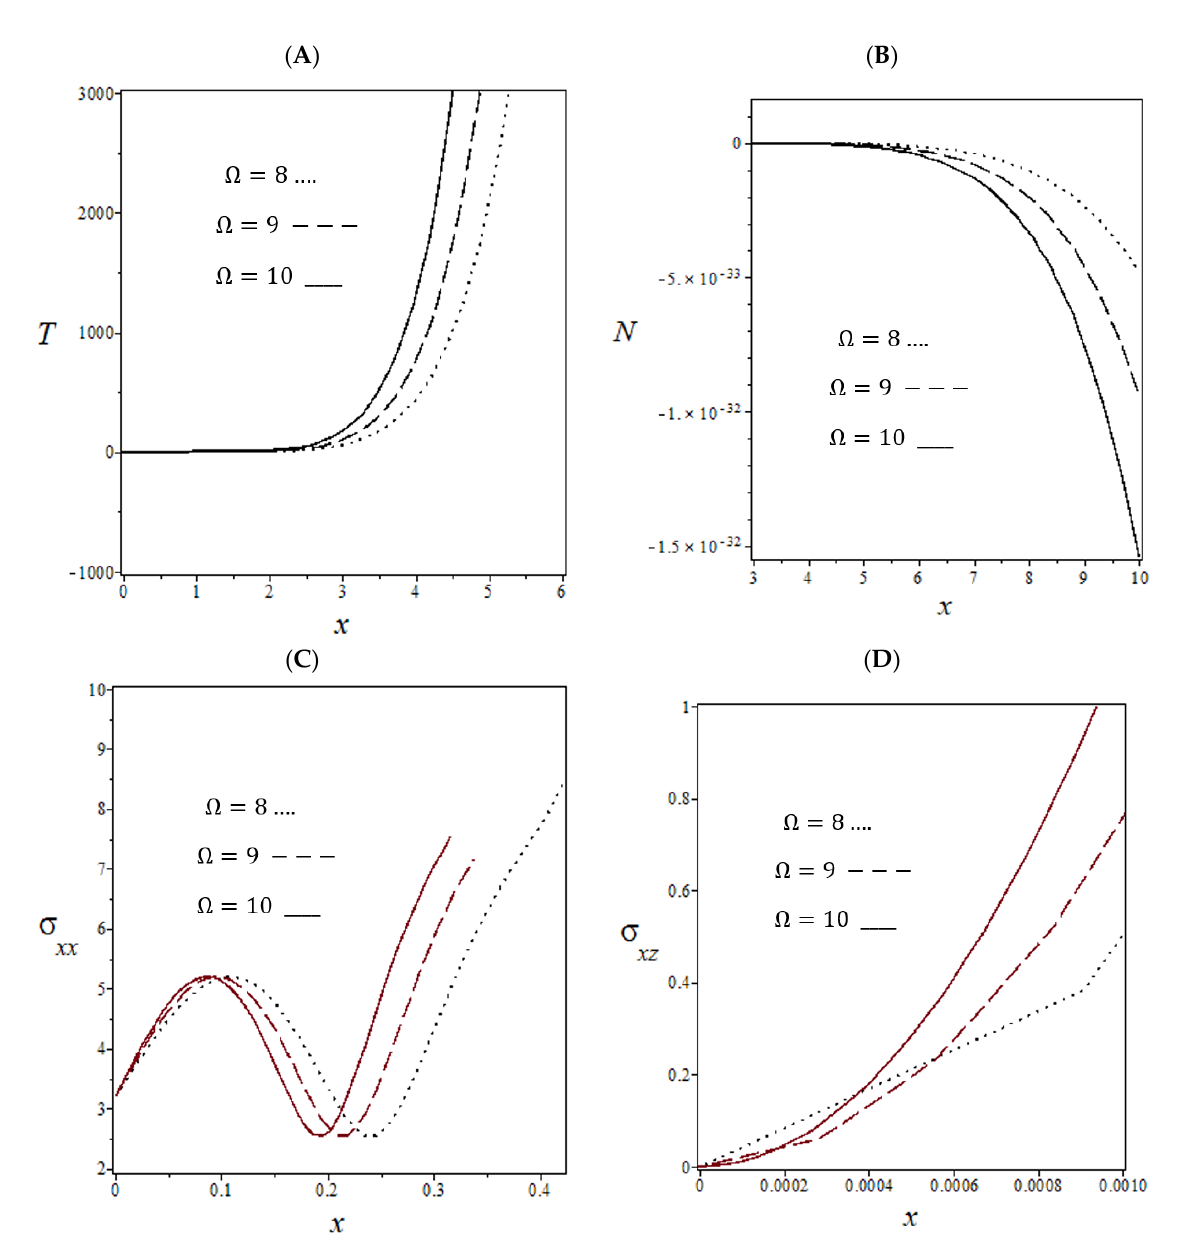
Figure 5. ( A–D ) Perturbation evolution for 𝑇(cid:4666)𝑥(cid:4667),𝑁(cid:4666)𝑥(cid:4667),𝜎 (cid:3051)(cid:3051) , 𝑎𝑛𝑑 𝜎 (cid:3051)(cid:3053) for the complex circular fre- Figure 5. ( A – D ) Perturbation evolution for T ( x ) , N ( x ) , σ xx , and σ xz for the complex circular fre- quency (wave number) when 𝜀 (cid:2871) = − 7.234118786x10 − 36 quency ω min = − 0.258 at K max = 0.25649 (wave number) when ε 3 = − 7.234118786 × 10 − 36 and with three small values of the rotation parameter Ω and with three small values of the rotation parameter Ω.